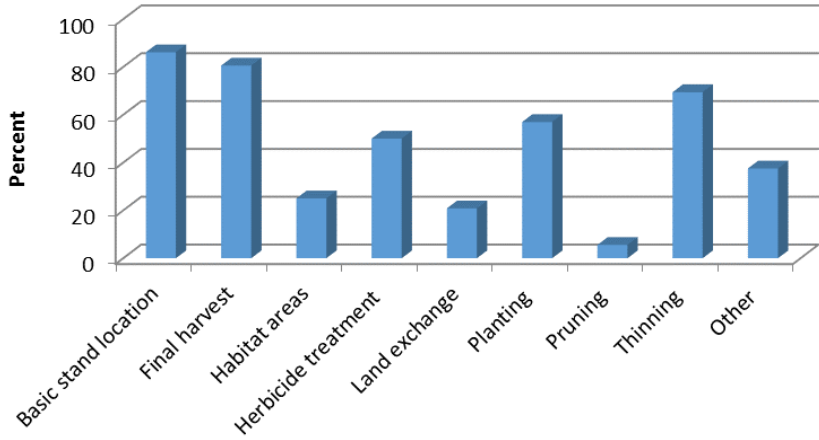
Figure 3. Types of maps and frequency with which maps are created by recent graduates from forestry programs at Mississippi State University, Oregon State University, and the University of Georgia.